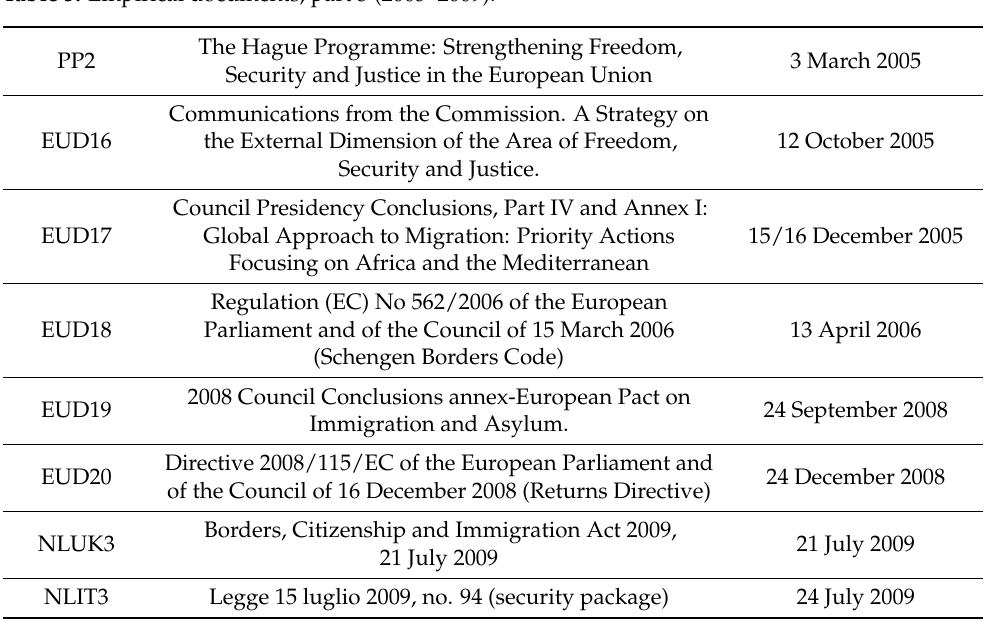
Table 3. Empirical documents, part 3